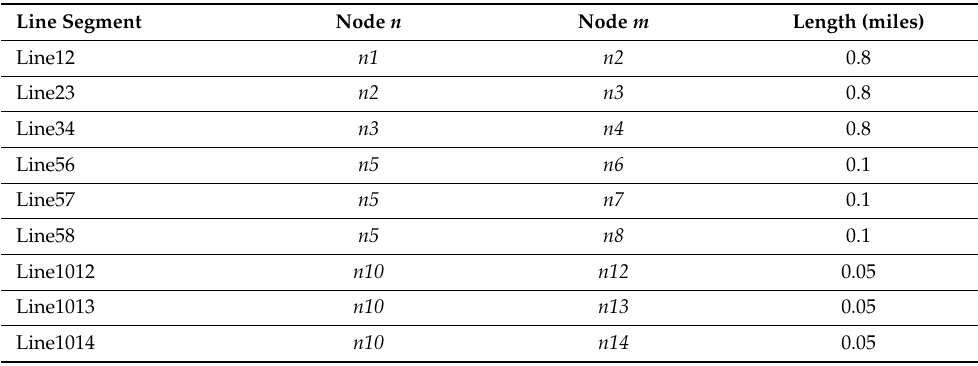
Table A1. Length of the distribution line